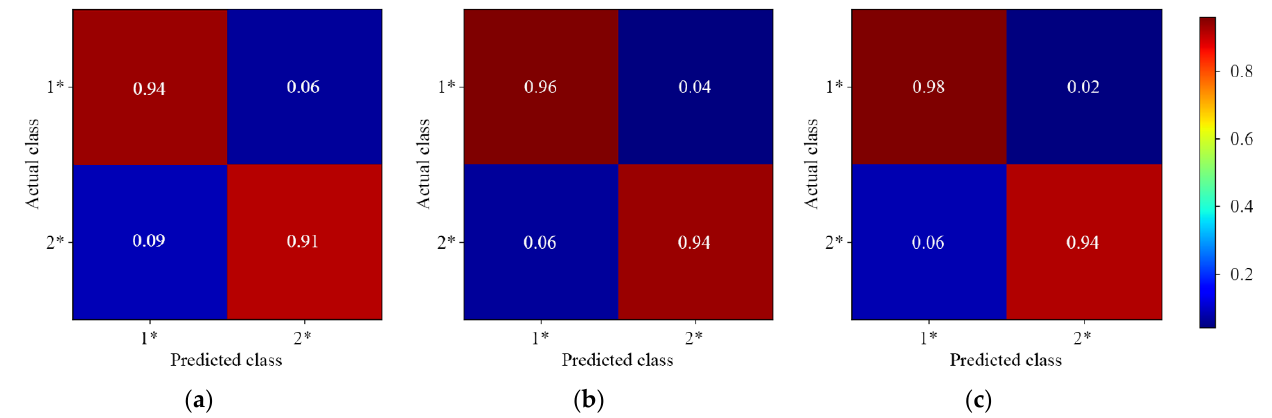
Figure 7. The normalized confusion matrix for two-level discrimination of beta-cypermethrin residues. ( a ) Single-depth 1D-CNN; ( b ) Symmetric multiscale 1D-CNN; ( c ) Asymmetric multiscale 1D-CNN.